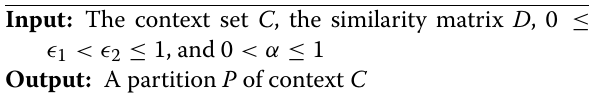
Algorithm 3 REDUN C